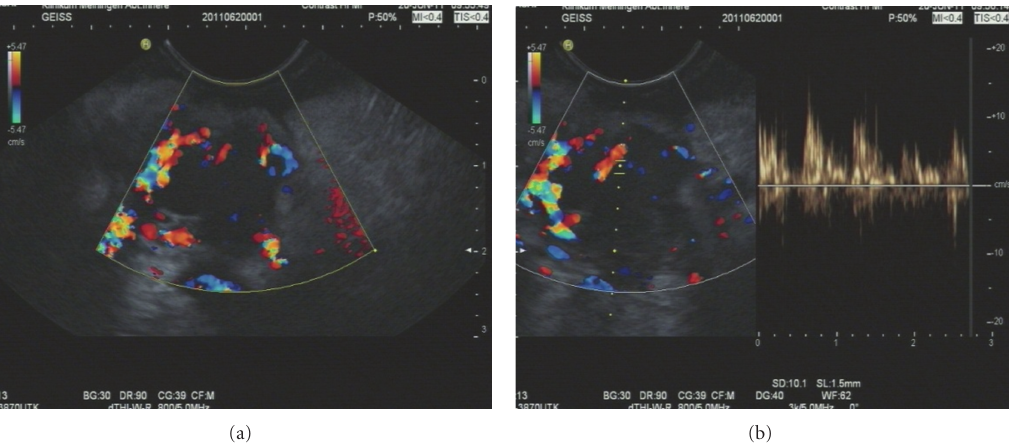
Figure 2: Contrast-enhanced high mechanical endoscopic ultrasound in a patient with pancreatic cancer (a) pancreatic cancer after influx of contrast enhancer (4.5 mL SonoVue); only a few vessels are visible, the lesion is visible within the colour Doppler window as the black area with the colour Doppler signals only on the edges; (b) pw-Doppler analysis reveals only arterial vessels; the atrial vessel signal appears in the right half of the picture in a pulsatile